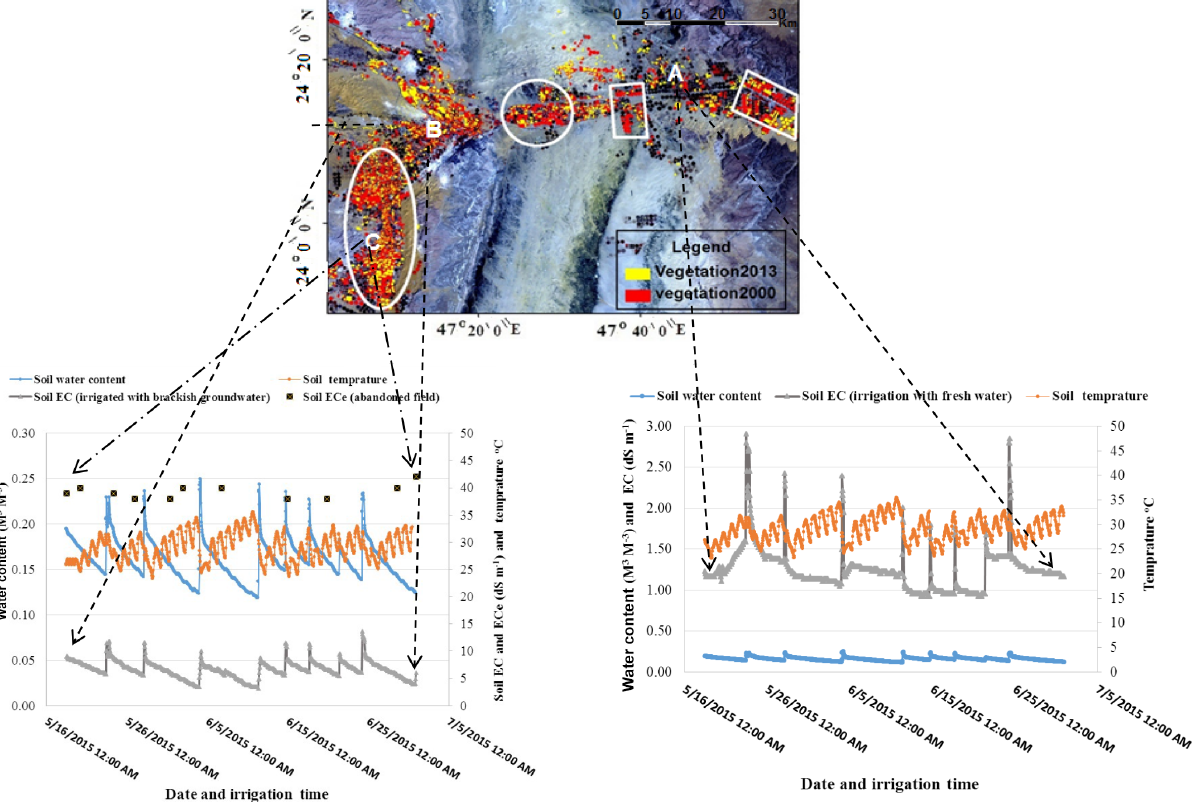
Figure 11. The changes of VC between years 2000 and 2013 linked to soil salinity, water content, and temperature at different fields in Al Kharj ecosystem: (a) field with no change of VC that used fresh water for irrigation (EC w = 1 . 1dSm − 1 ); (b) deteriorated field that used saline brackish water for irrigation (EC w = 6 . 5dSm − 1 ); (c) abandoned field with no irrigation (EC w = 10 . 2dSm − 1